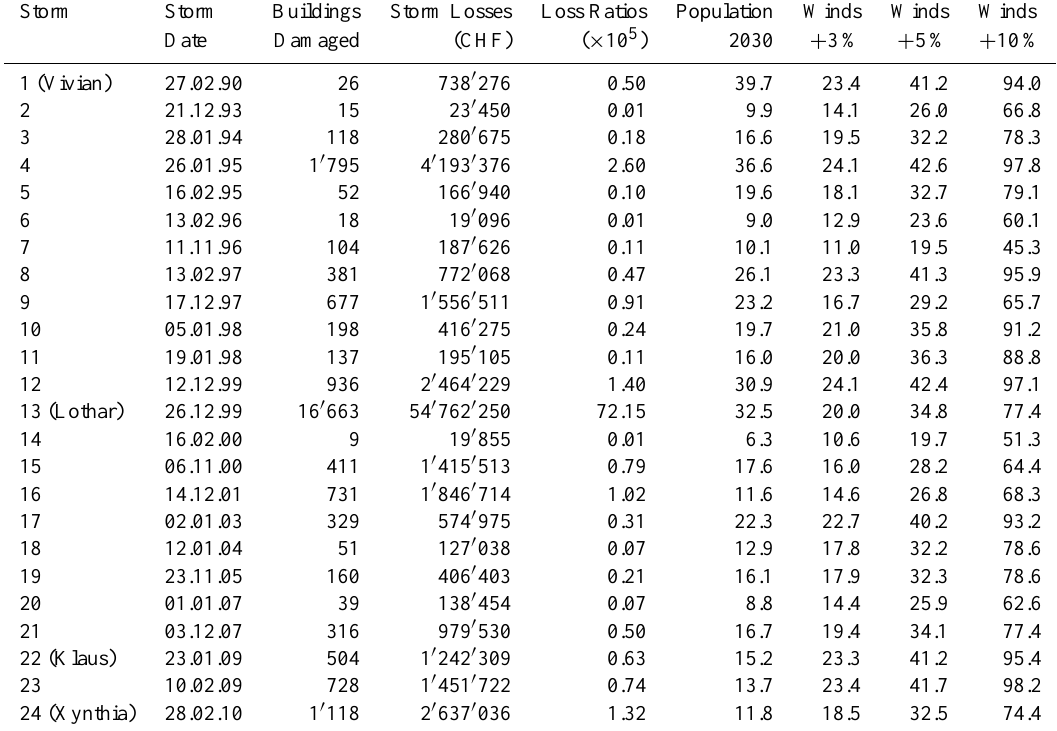
Table 1. List of the 24 studied storm events. The storm dates as well as the observed number of buildings damaged and total economic losses (in Swiss Francs, indexed to year 2000 values) are listed in columns 2, 3 and 4, respectively. Column 5 provides the loss ratios, i.e. the losses divided by the total insured sums for the canton of Vaud, expressed in CHF 0.01 per CHF 1000 insured. The last 4 columns list the economic shift (in percent) due to population growth (based on the estimated population in 2030) and enhanced wind speeds (for increases in wind speeds of 3%, 5% and 10%, respectively): comparisons are made with the original calculated losses for each